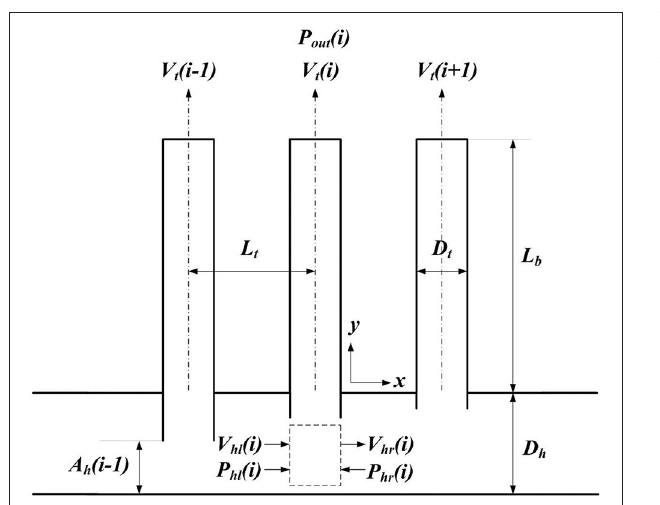
TABLE 1 | The insert length of each tube for three cases with the best